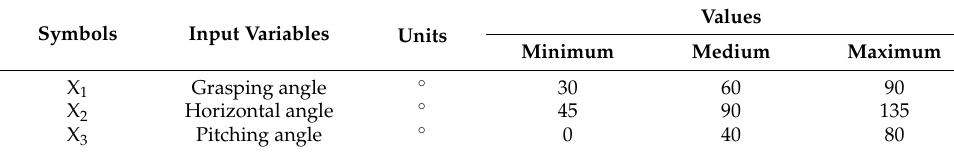
Table 2. Factors and levels of the Box–Behnken Design.